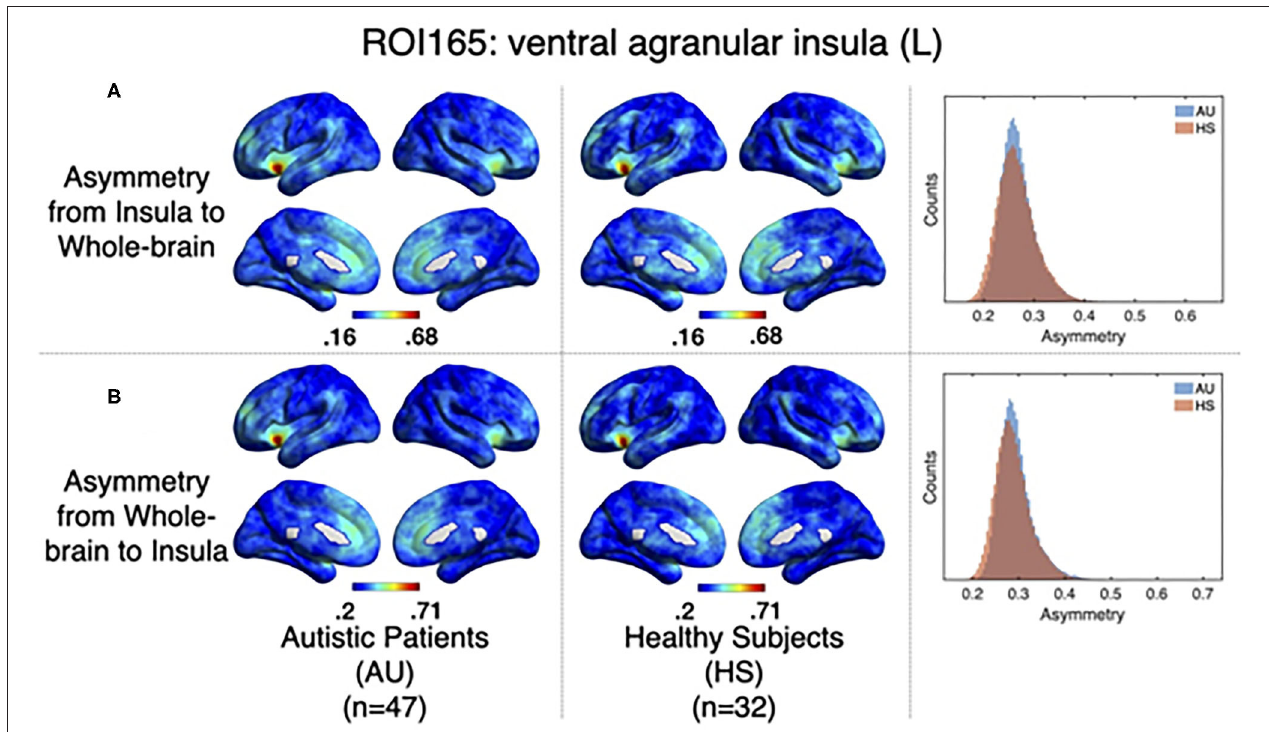
FIGURE 6 | Directionality computed from-insula and to-insula for all brain voxels. (A) Shows group averages for asymmetry from insula subregion mean time series to the rest of the brain for Autistic patients (left columns), Healthy subjects (middle columns), and histograms showing the distribution of these directionalities. (B) Shows the same computations but for directionality from all the brain to the Insula subregion mean time